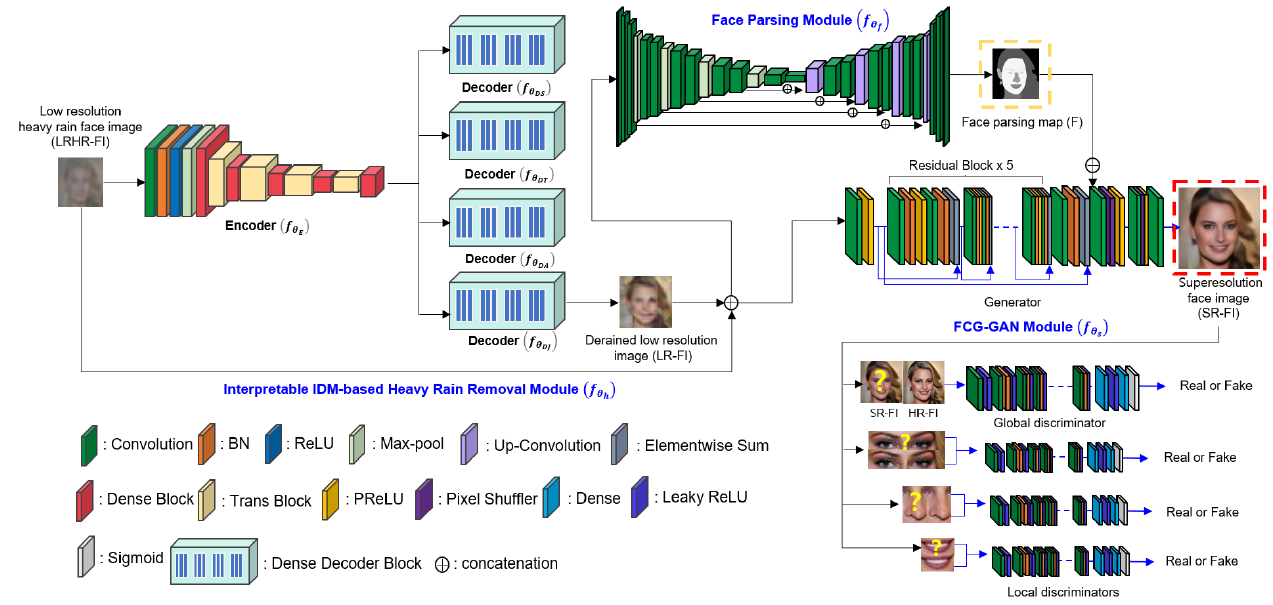
Figure 3. Proposed deep learning network for heavy rain face image restoration: First, rain streaks and rain accumulation are removed approximately by the interpretable IDM-based heavy rain removal module, and then a face parsing module is applied to find informative facial features. Finally, FCG-GAN module is used to generate SR-FIs and to boost the facial structure expression based on local facial discriminators.